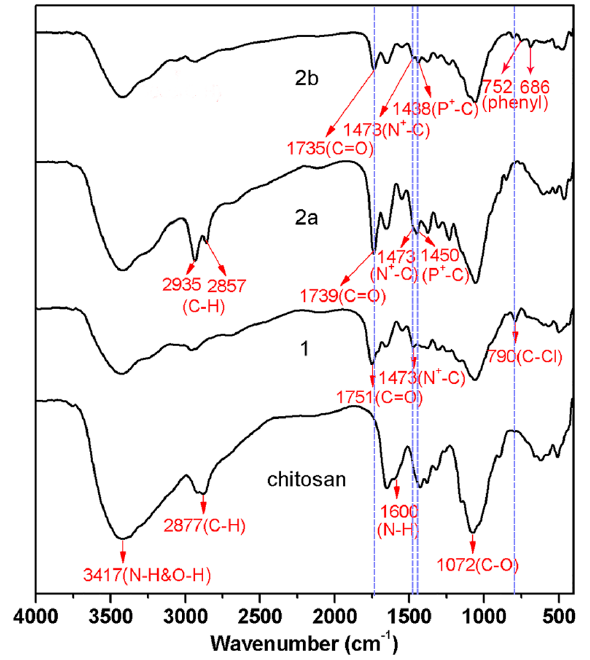
Scheme 1. Synthetic route to the novel chitosan derivatives.